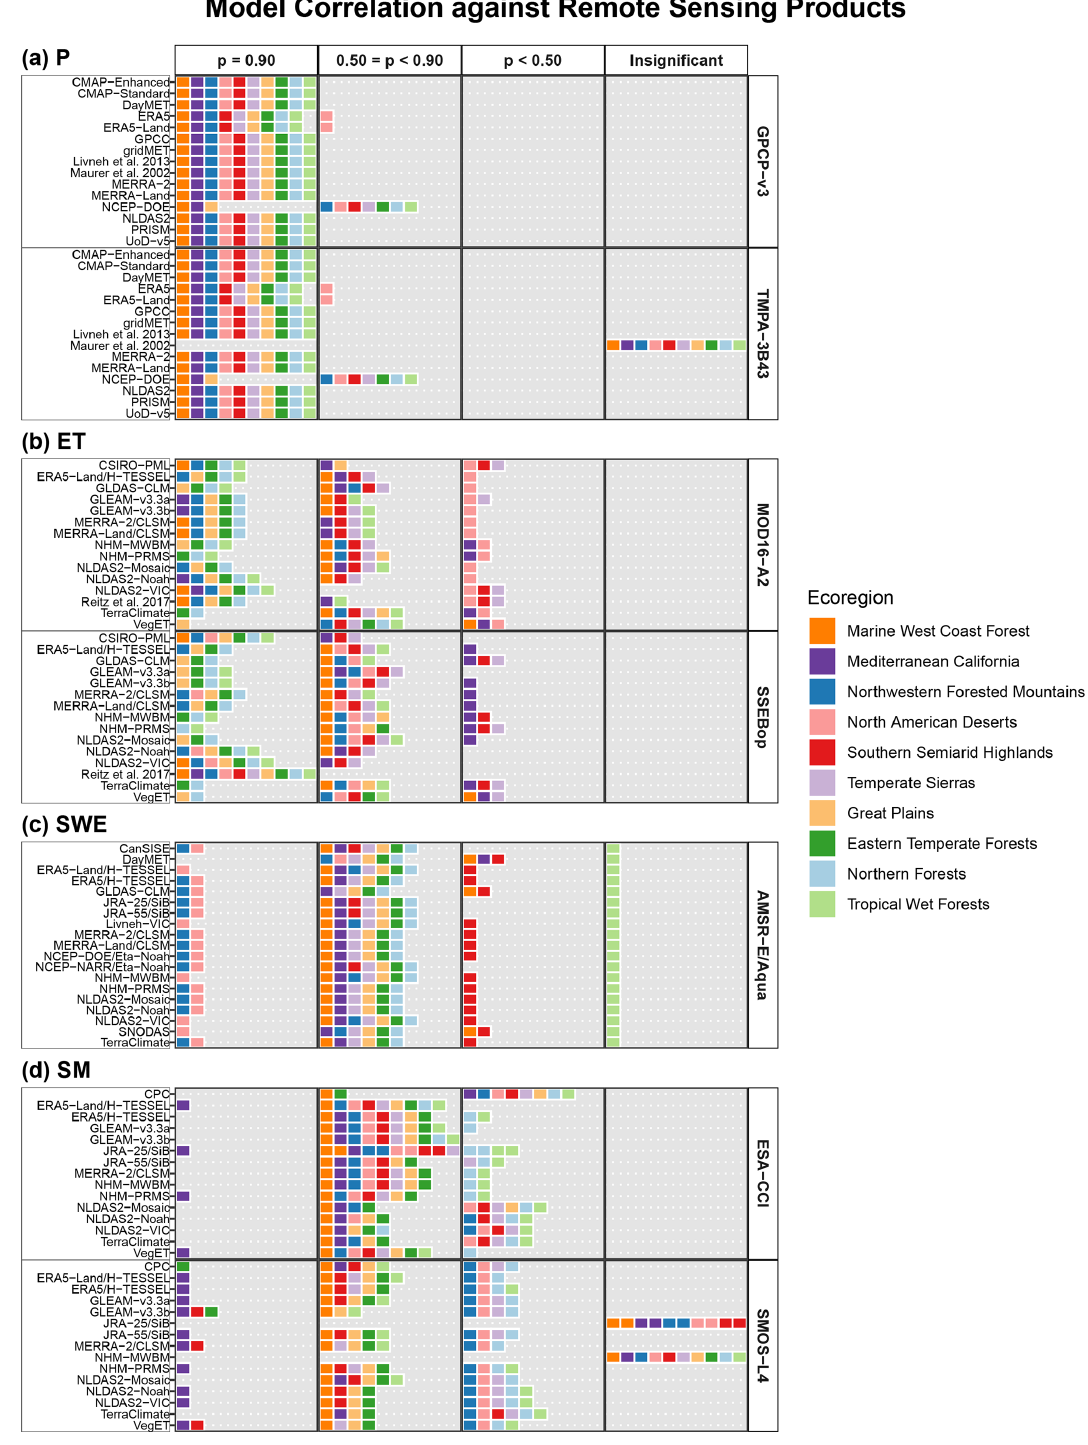
Figure B6. Distribution of hydrologic model and reanalysis data set correlation against remote sensing products using Spearman’s rho ( ρ ), provided by water budget component. Values of ρ are binned by > 0 . 90, 0.50–0.90, < 0 . 50, and statistically insignificant ( p> 0 . 05). Rectangles are color paired with their associated ecoregions (Fig. 1). Water budget components shown are precipitation (precip), evapotranspiration (ET), snow water equivalent (SWE), and soil moisture